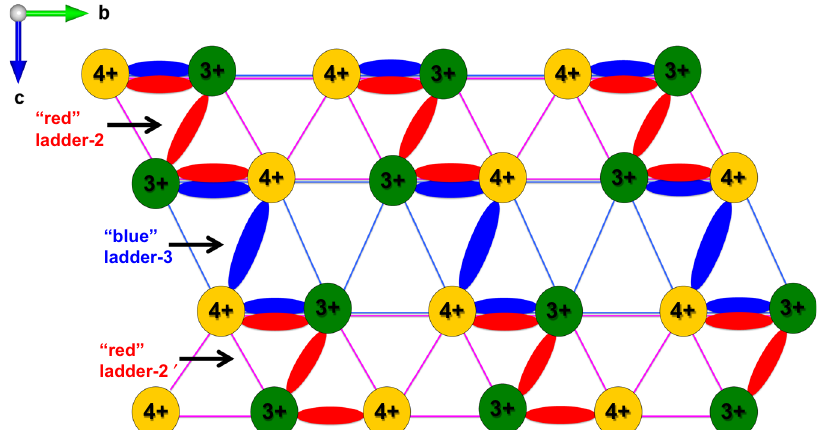
Fig. 8 Z -order in the two-leg corner- and edge-sharing RuO 6 zigzag ladders. The sketch of self-organized Z -clusters in the low-temperature phase, formed within the edge-sharing red and corner-sharing blue ladders of NaRu 2 O 4 lattice in the low-temperature connected in two different forms: the corner- (blue or green ladders) or the edge- (red ladders) sharing RuO 6 octahedra. The t 2g energy-level sketch with respective electron fi llings is shown for a charge-ordered state, so-called Z -order (left panel) and Ru- dimer (right panel) in Fig. 9d.